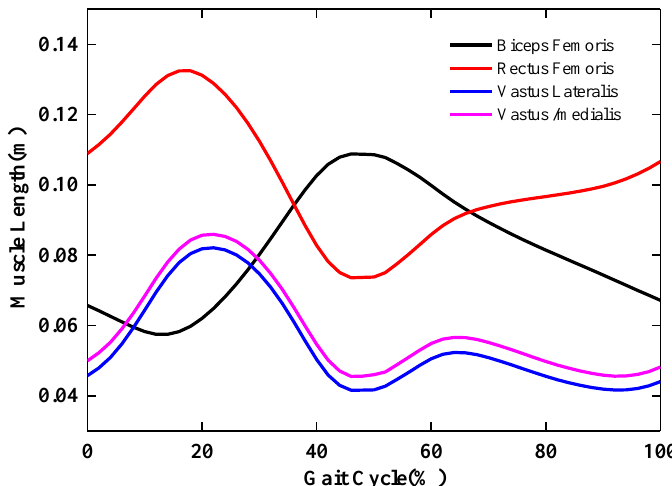
Figure 1. Curve of thigh muscle length in a single gait cycle.